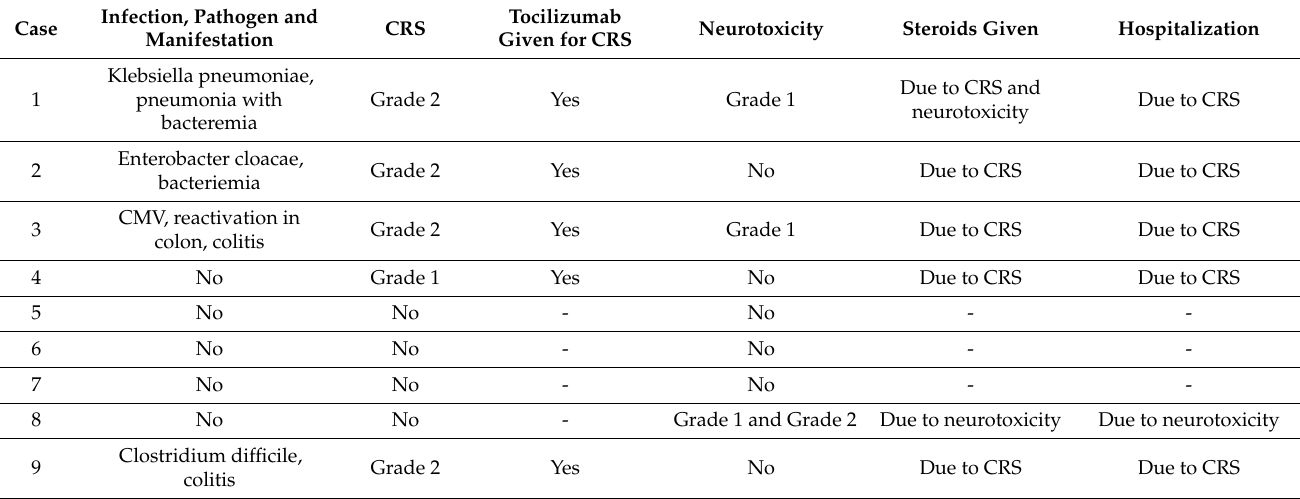
Table 4. Adverse effects infection, cytokine release syndrome (CRS) and